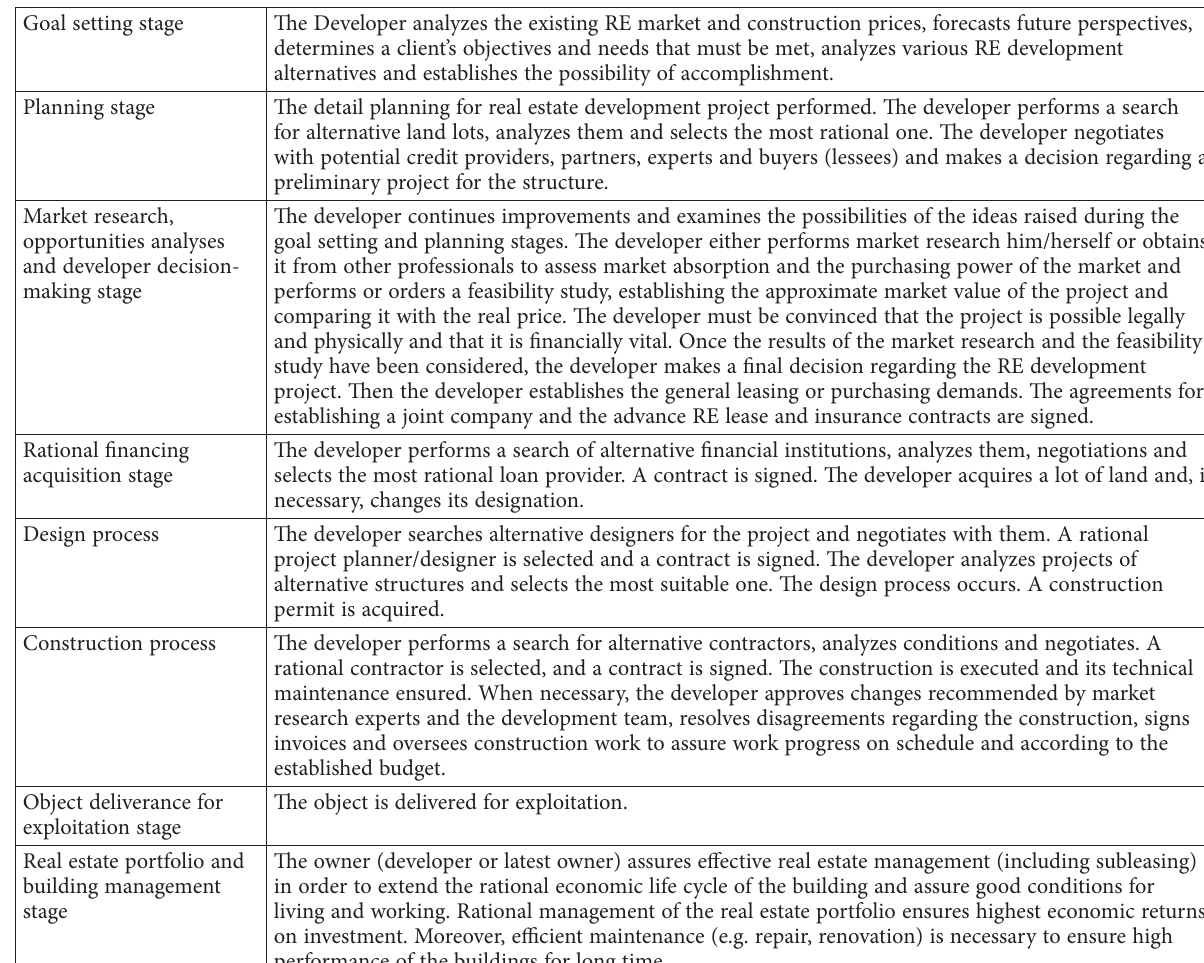
Table 1. Real estate development